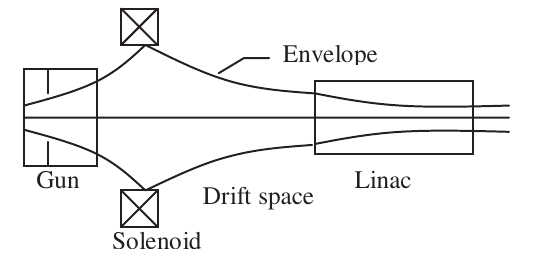
FIG. 5. Scheme of emittance compensation for a compact rf gun (cid:9) solenoid (cid:9) drift space (cid:9) linac system.